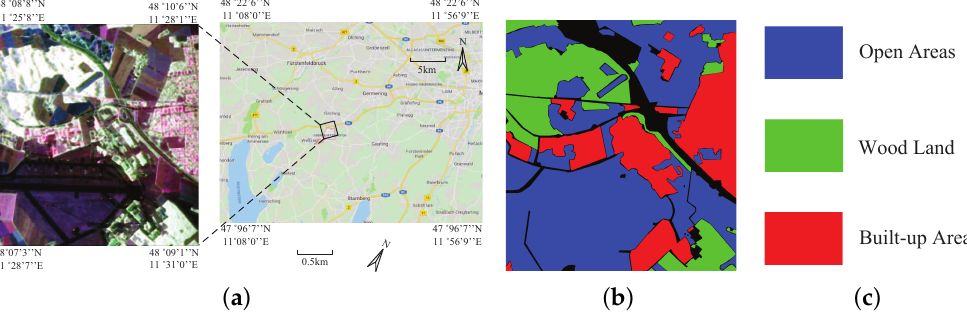
Figure 4. Oberpfaffenhofen. ( a ) Left: PauliRGB image with its coordinate, right: the photo of near area with its coordinate, which is from Google Maps. ( b ) Ground truth map. ( c ) Color